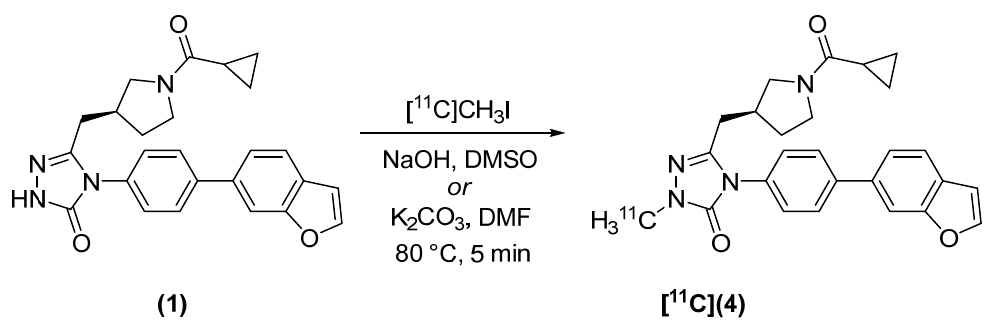
Figure 2. Radiosynthesis of [ 11 C]( 4 ).